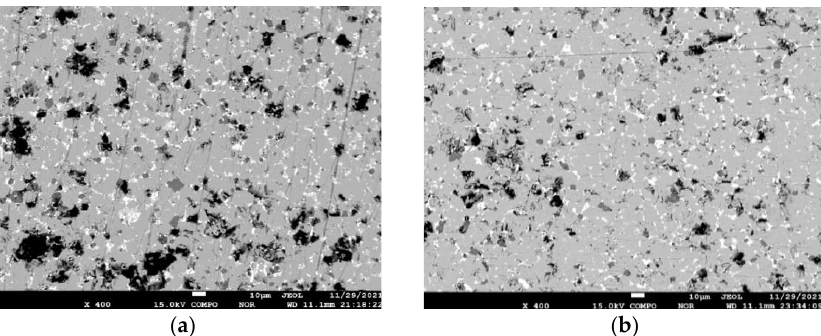
Figure 7. Assembly of surface elements of D71 valve plate. ( a ) Surface elements for ordinary-gradient valve plate; ( b ) Surface elements for high-gradient valve plate.